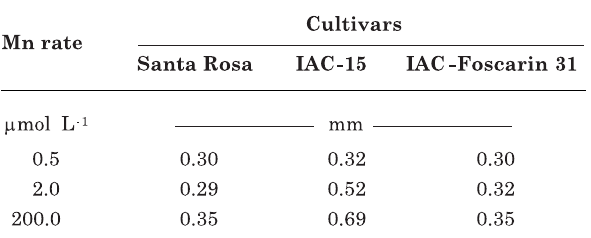
Table 2. Average diameters of root cross-sections of the three soybean cultivars Santa Rosa, IAC-15 and IAC-Foscarin 31, as related to rates of 0.5;